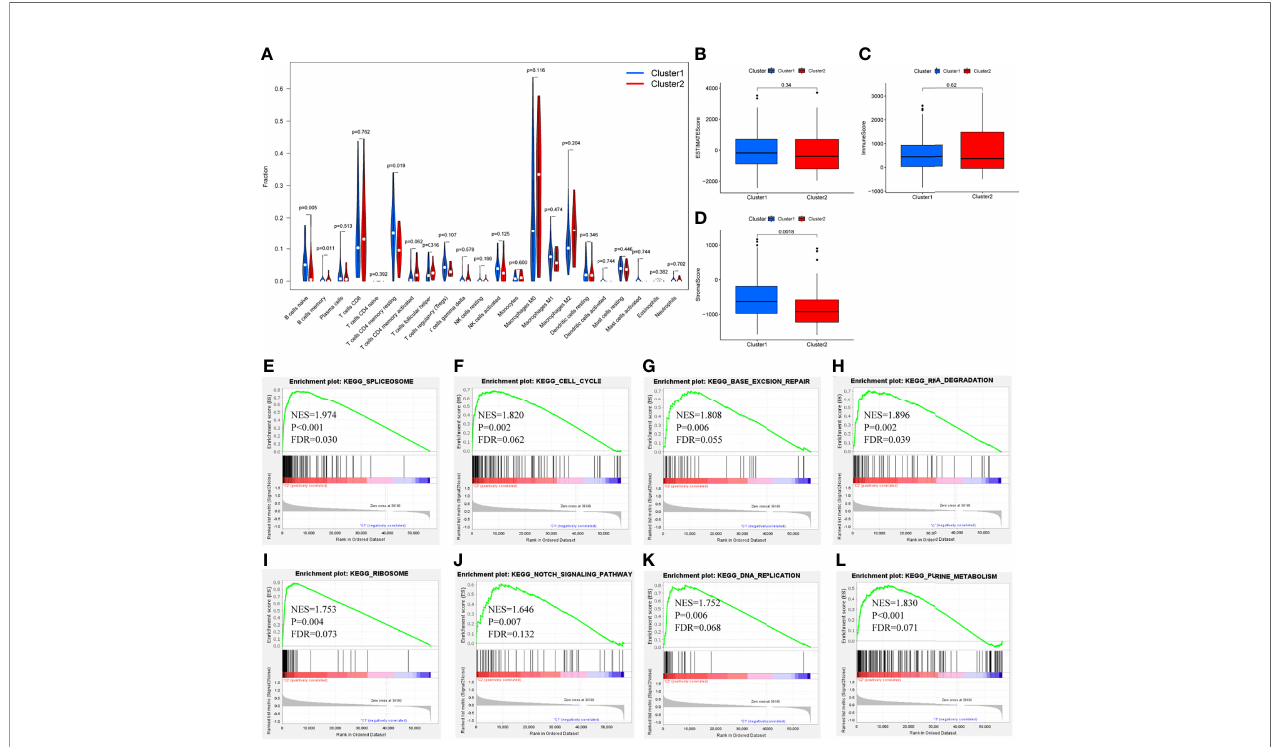
FIGURE 4 | Differential fraction, box plots and enrichment analysis. (A) Differential fraction comparison of immune cells, (B – D) Box plots of estimatescore, immunescore, and stromalscore by clusters, (E – L) Enrichment analysis of KEGG pathways of lncRNAs-related.